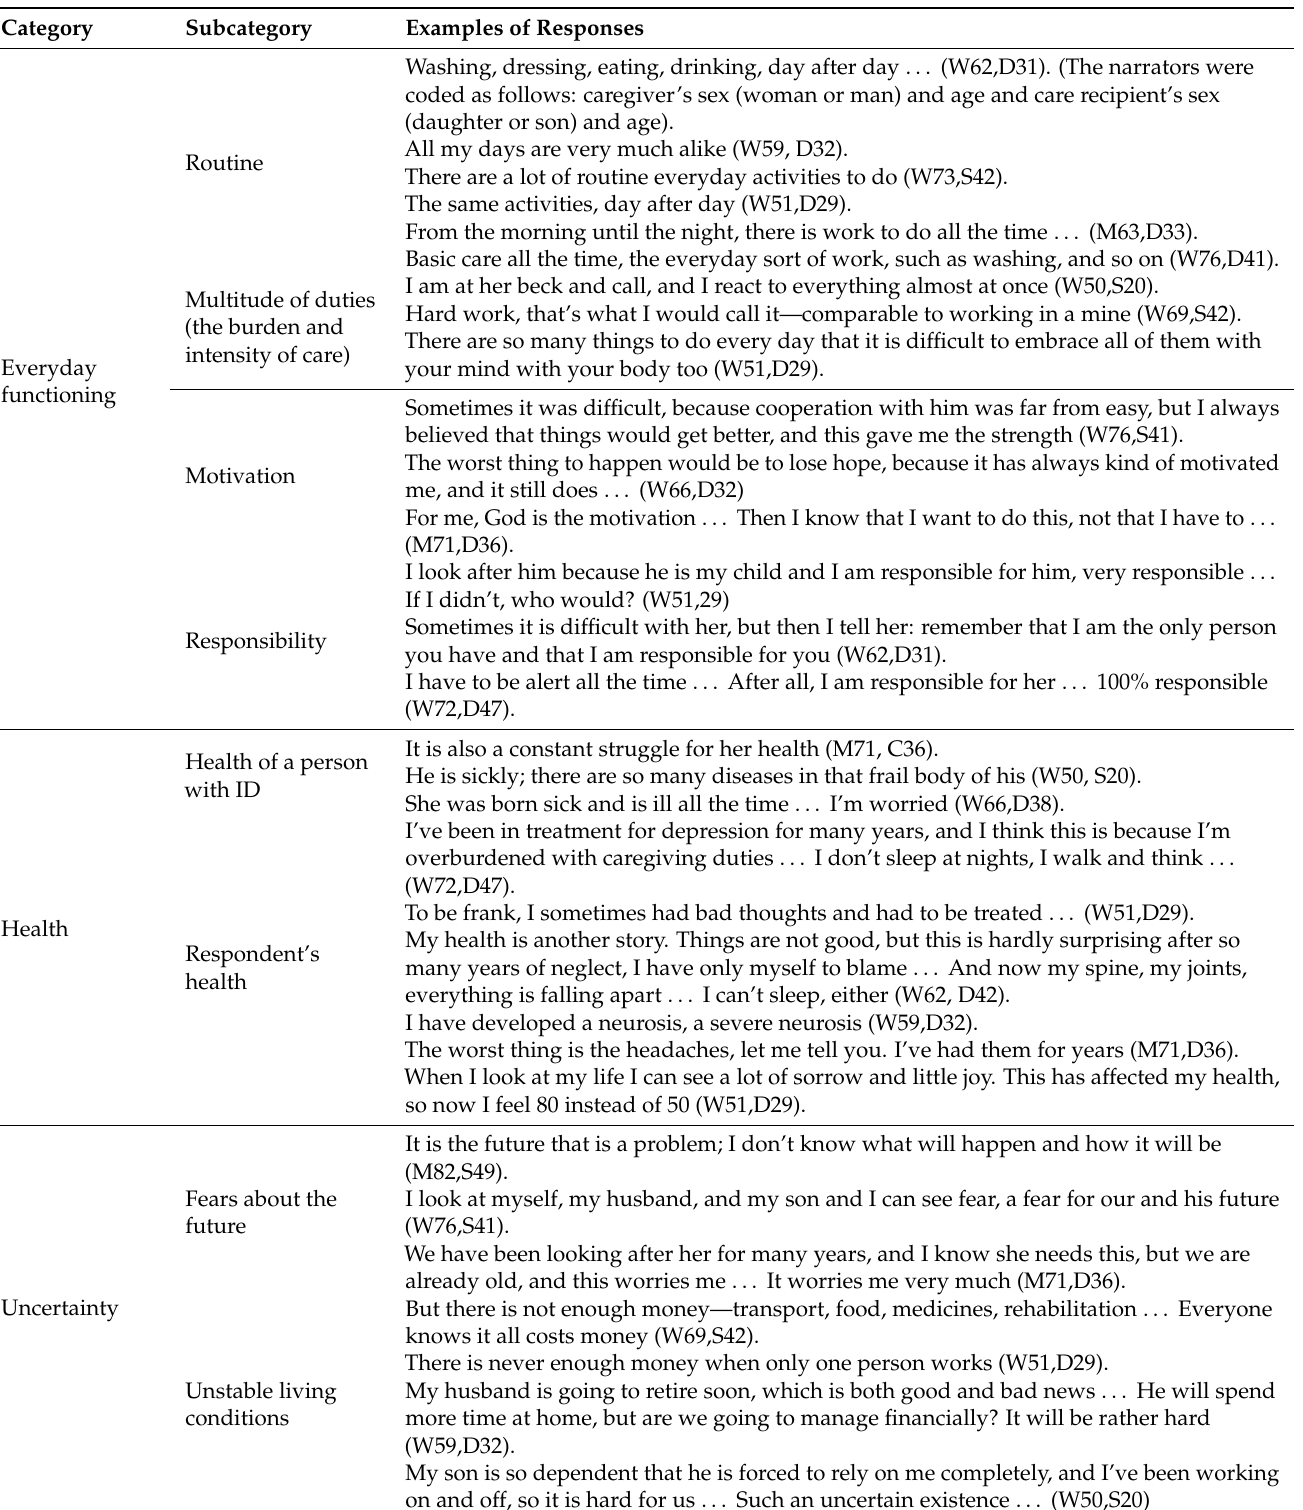
Table 1. Thematic categories and